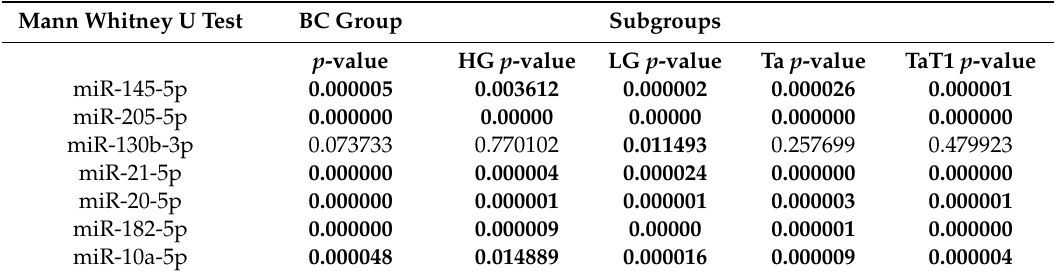
Table 5. Results of Mann-Withney U test in bladder cancer (BC) group and in subgrups divided according to grade or stage.